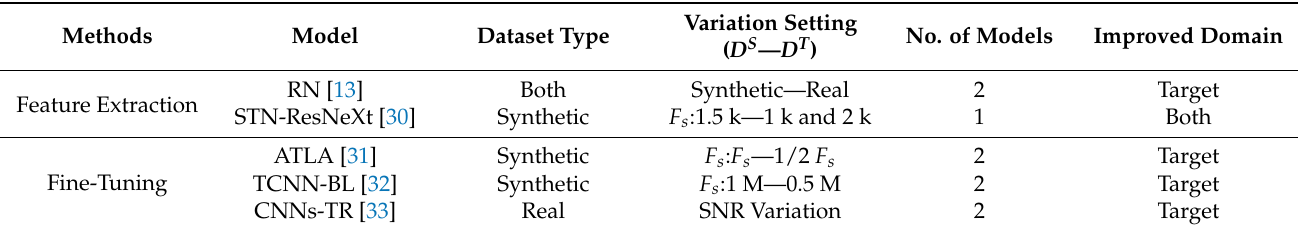
Table 1. Different transfer learning methods in